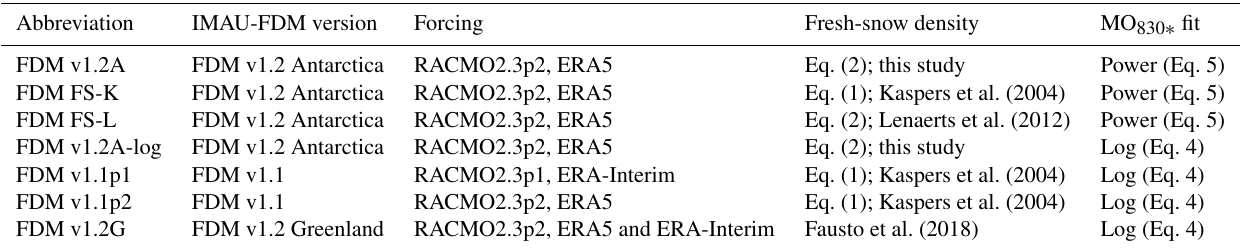
Table 1. Abbreviations and characteristics of IMAU-FDM versions used in this